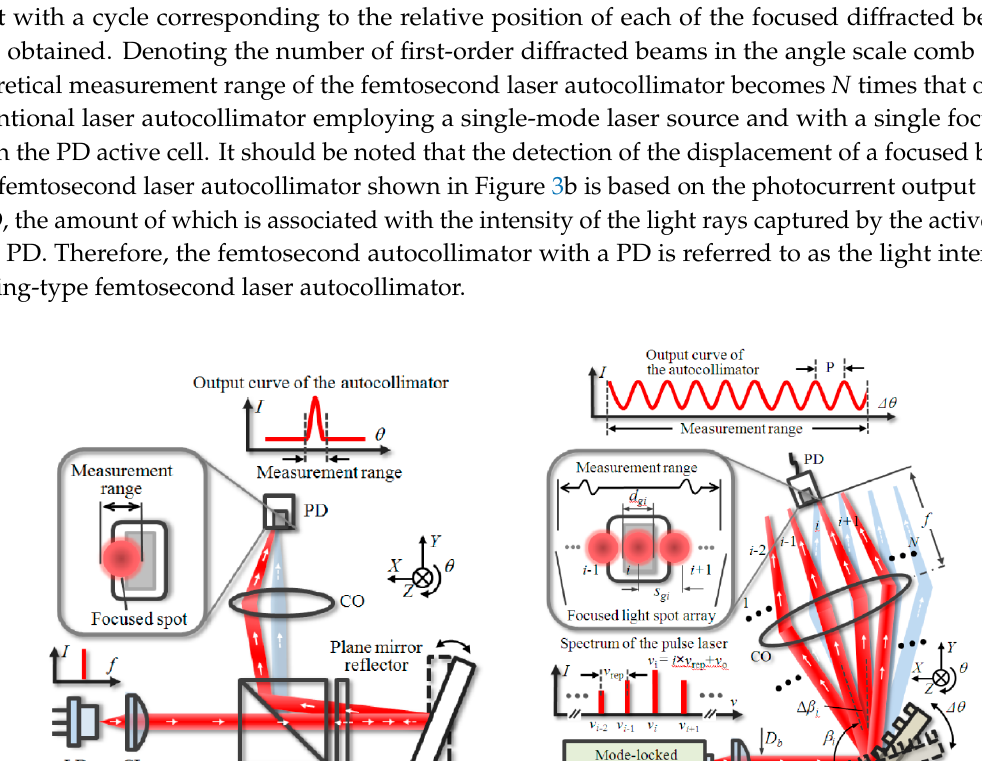
Figure 4. Optical setup of the mode-locked femtosecond laser autocollimator [55]: ( a ) A schematic of the optical setup; ( b ) A photograph of the optical setup.